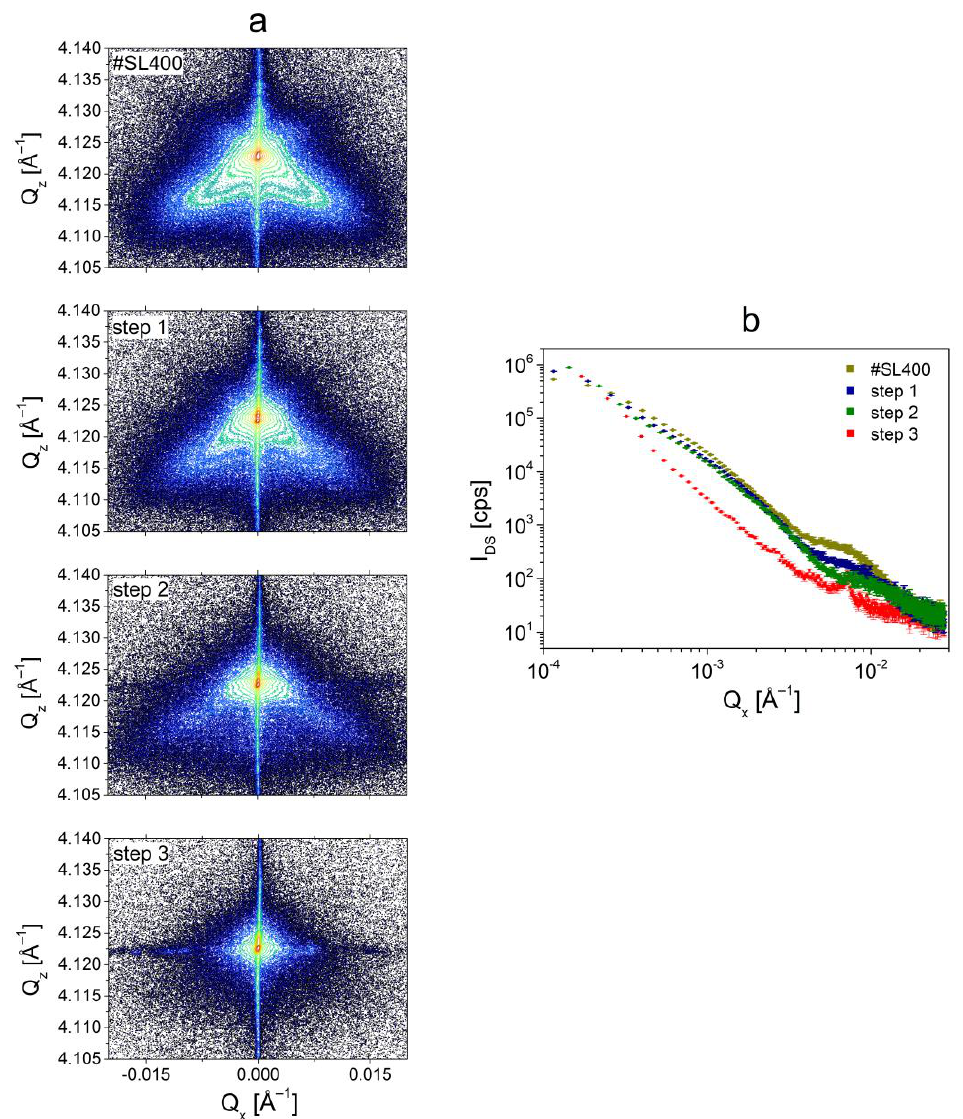
Figure 8. ( a ) Symmetrical reciprocal space maps of #SL400 superlattice before and after each step of dry etching. ( b ) The distribution of I DS as a function of Q x for #SL400 before and after each etching.